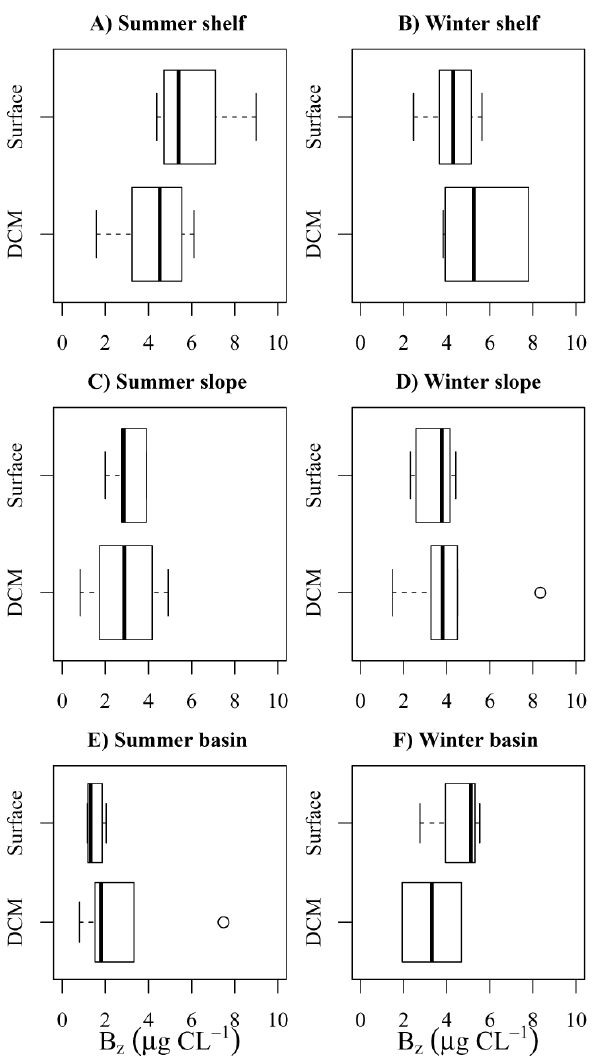
Fig. 3. Box plots of microzooplankton biomass ( B z ) .